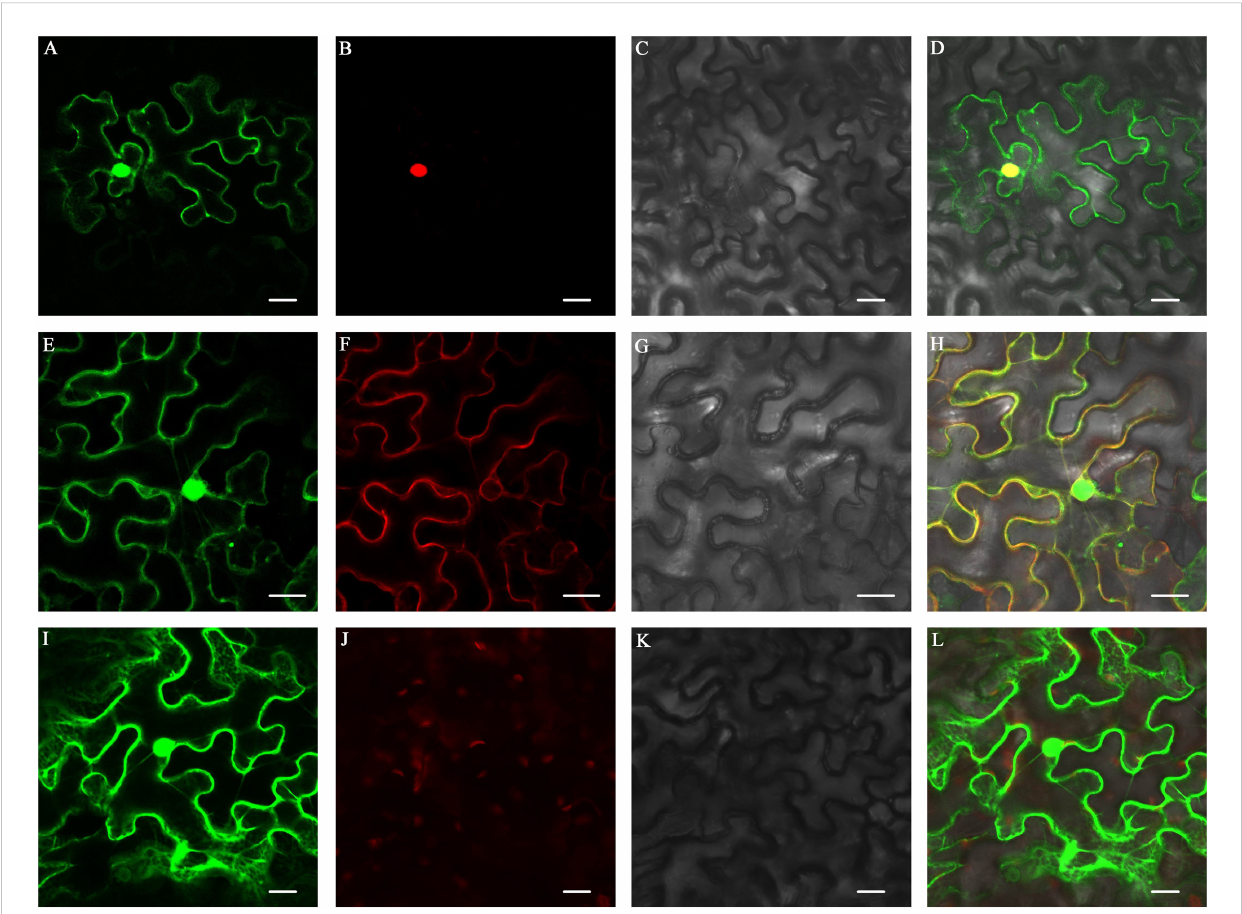
FIGURE 7 Subcellular localization of ZjFAS2. Colocalization of ZjFAS2-GFP (A) and AtH2B-RFP (B) in the tobacco leaves. The bright- fi eld image (C) and merged image (D) are also shown. Colocalization of ZjFAS2-GFP (E) and AtPIP2A-RFP (F) in the tobacco leaves. The bright- fi eld image (G) and merged image (H) are also shown. (I) The green fl uorescent signal of null-GFP in the tobacco leaves. (J) The red fl uorescent signal in the same tobacco leaves as (I) . (K) The same tobacco leaves as (I) under bright fi eld. (L) The merged image of (I) , (J) and (K) . Bars = 20 m